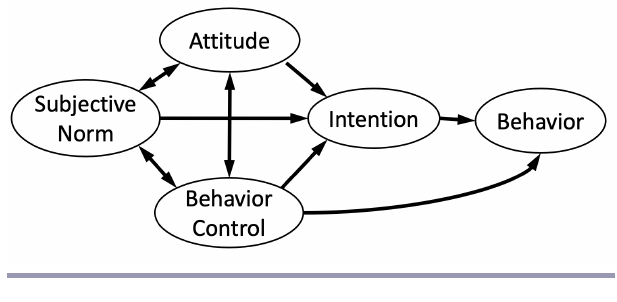
Fig. 2 . Determinants of behavior and their relations according to the Theory of Planned Behavior (Ajzen